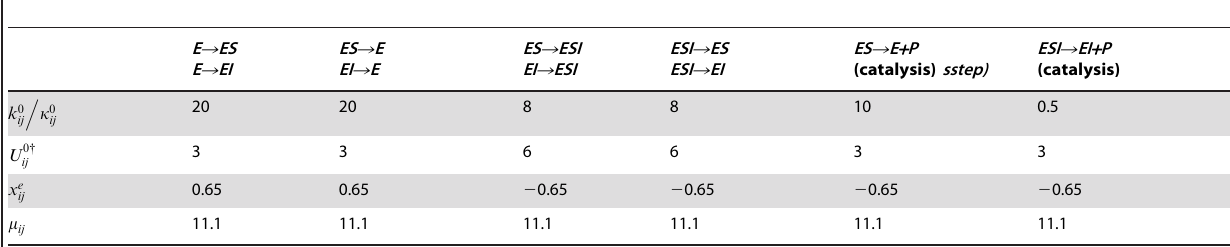
Table 4. Model parameters for transitions between different enzyme states for the reaction scheme in Fig. 1c.